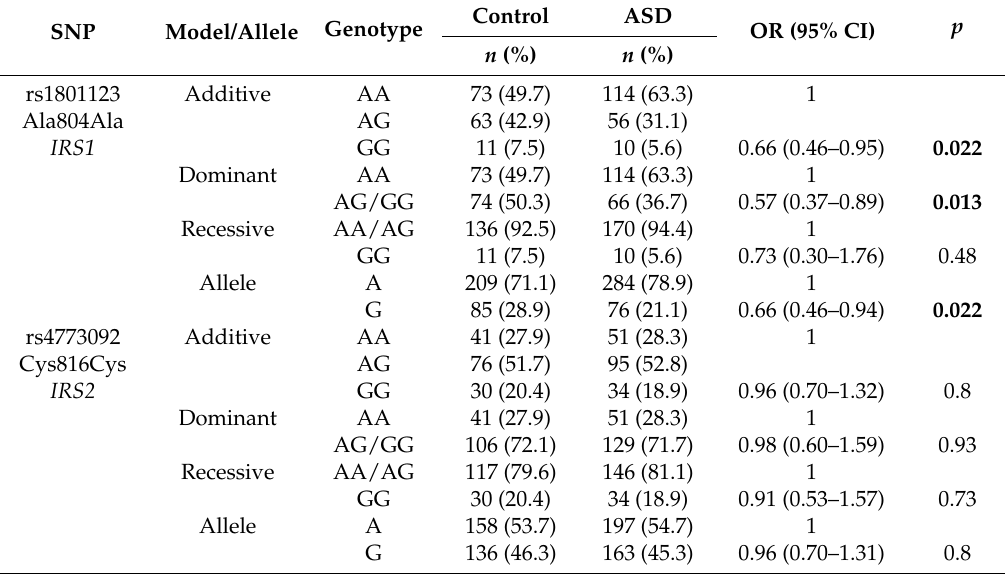
Table 1. Multiple logistic regression analysis of IRS1 and IRS2 polymorphisms in autism spectrum disorder (ASD) patients and control subjects.